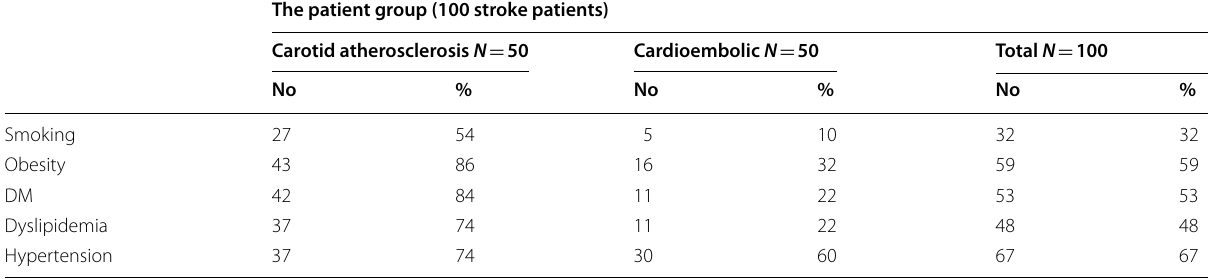
X mean, SD standard deviation, X 2 Chi‑square test Table 2 Vascular risk factors for atherosclerosis among patients group The patient group (100 stroke